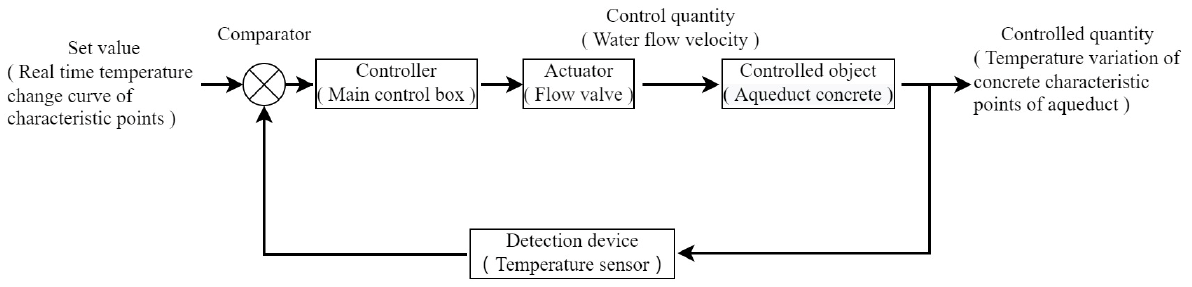
Figure 2. C losed-loop control block diagram.